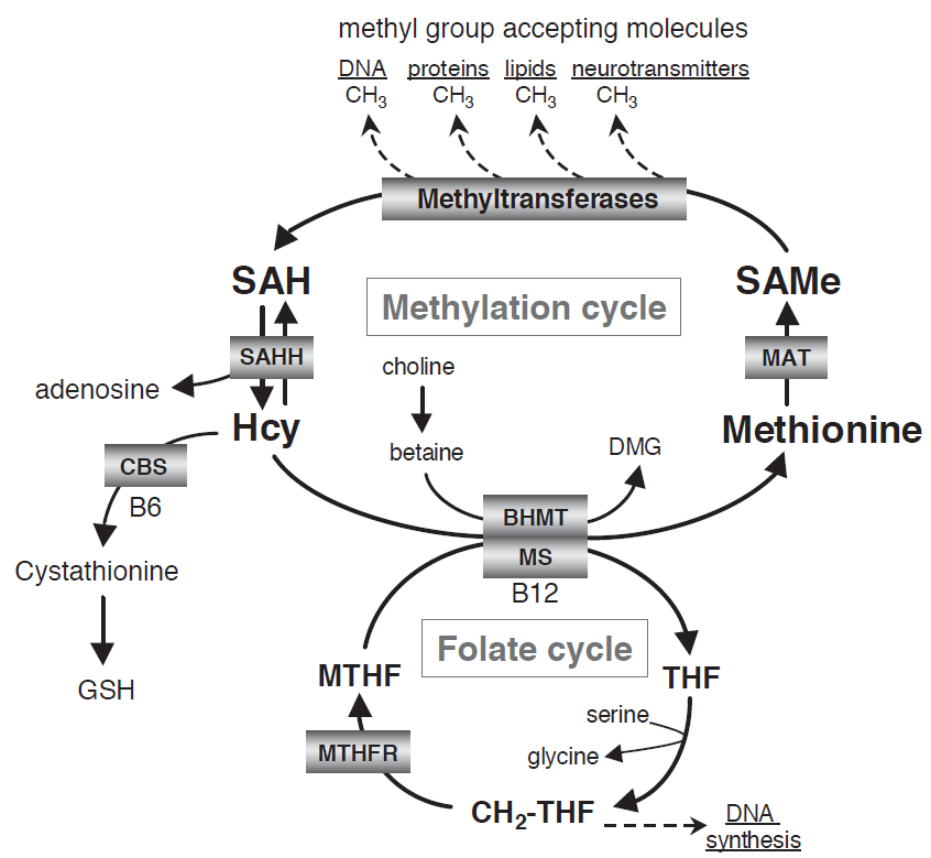
Figure 1. One-carbon folate methylation cycle [38]. BHMT, betaine:homocysteine methyltransferase; CBS, cystathionine- β -synthetase; DMG, dimethylglycine; GSH, glutathione; Hcy, homocysteine; MAT, l-methionine S -adenosyltransferase; MTHF, 5-methyltetrahydrofolate; MTHFR , 5-methyltetrahydrofolate reductase; SAH, S -adenosylhomocysteine; SAHH, S -adenosylhomocysteine hydrolase; SAMe, S -adenosylmethionine; THF,